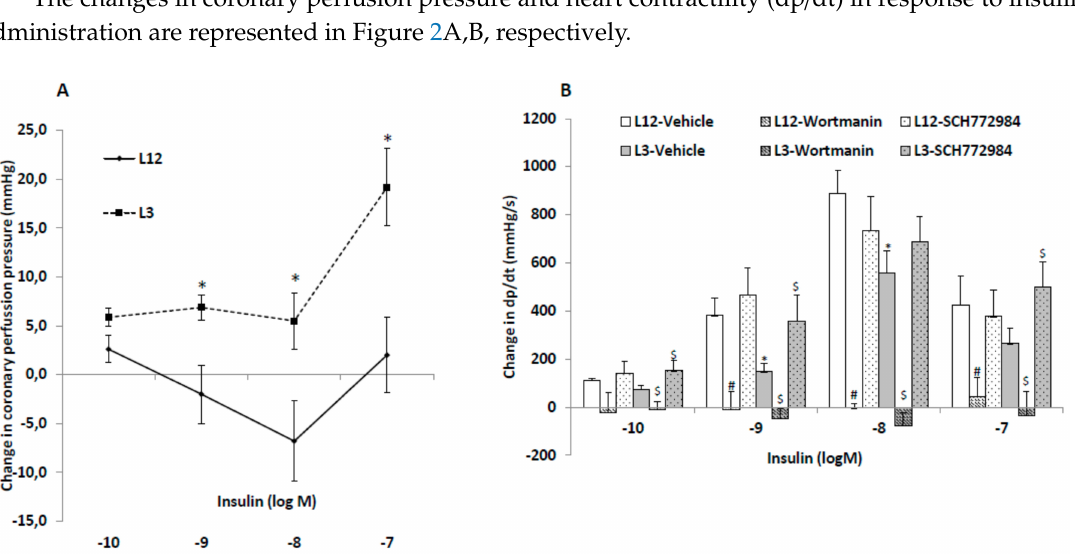
Figure2. Changesincoronaryperfusionpressure( A )anddP / dt( B )inresponsetoinsulin(10 − 10 –10 − 7 M) compared to basal levels before insulin administration, in perfused hearts from rats raised in L12 or L3 litters, in the absence or presence of the phosphoinositide 3-kinase (PI3K) inhibitor wortmanin (10 − 6 M) or the inhibitor SCH-772984 (3.10 − 6 M). Note: * p < 0.05 di ff erence between L3 and L12; # p < 0.05 di ff erence between hearts in the presence or absence of wortmannin; $ p < 0.05 di ff erence between hearts in the presence or absence of SCH-772984. Values are represented as mean ± SEM; n = 6–9 rats / experimental group. Data were analyzed by Student’s t -test for each insulin